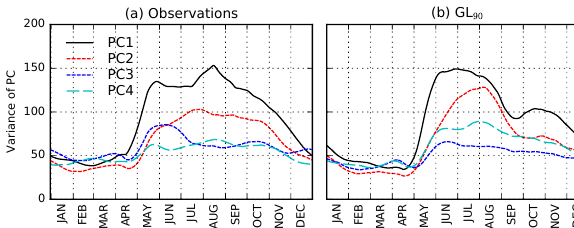
Figure 9. The 30-day smoothed annual cycle of the variance of the leading four pseudo principal components for (a) AVHRR OLR and ERA-Interim u 850, (b) GL 90 . Note that year-round data have been used for the projections, even though the EOFs were computed from boreal summer data only; compare to Lee et al. (2013), Fig.